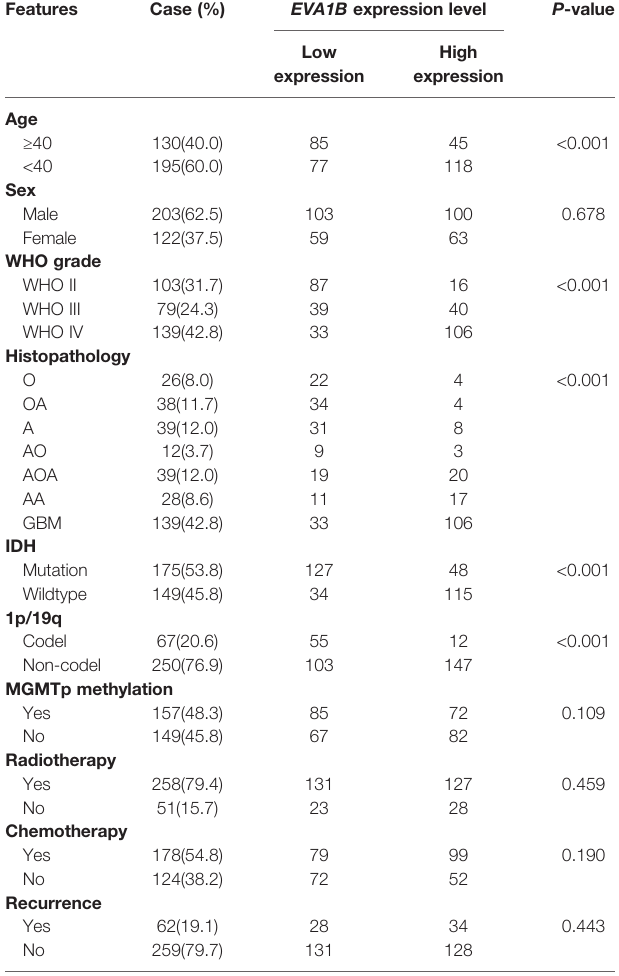
TABLE 1 | The correlation between the expression of EVA1B and clinicopathological factors (CGGA). Features